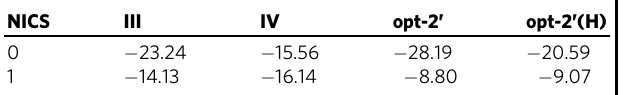
Table 2 Calculated NICS values (CBB ring, in ppm) of V, Table 1 Calculated NICS values (BBB ring, in ppm) of III – V,